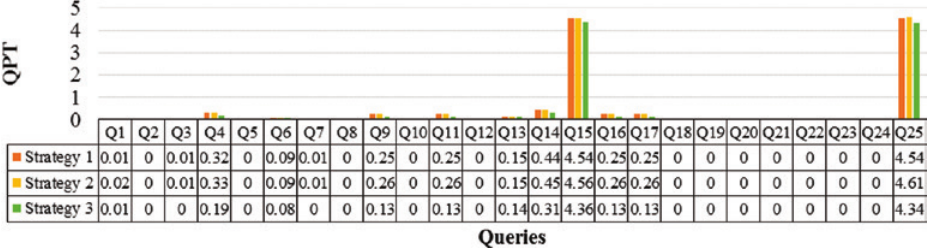
Figure 14: QPT Analysis of Three Strategies on Three Ontologies and A-BOX of Size 5L.